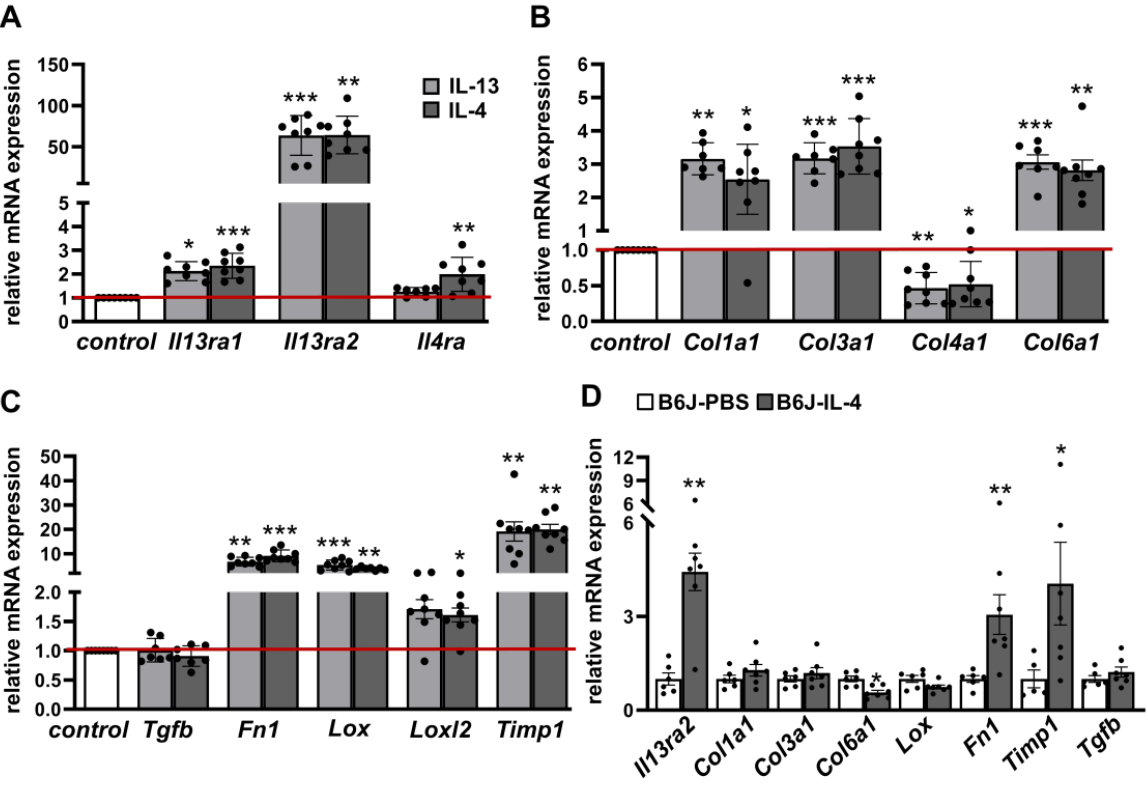
Figure 1. IL-13 and IL-4 induce fibrosis-related genes in adipose tissue of C3H mice and partial in WAT from B6J mice injected with IL-4. White adipose tissue (WAT) explants from C3H mice (n = 7–8) were stimulated either with IL-13 (50 ng/mL) or IL-4 (50 ng/mL) or non-stimulated (control) for four days. mRNA expression of cytokine receptors ( A ), collagens ( B ) and other fibrosis markers ( C ) are given as fold change compared to control condition. B6J mice were fed HFD over 6 weeks and were injected every two days with recombinant mouse IL-4 (66 µ g/kg body weight) complexed with anti-IL-4 (333 µ g/kg body weight) or PBS intraperitoneally (i.p.) for the final 2 weeks of feeding (n = 5–7). mRNA expression of Il13ra2 and fibrosis markers are given as fold change compared to PBS condition ( D ). Data represented as mean ± SEM. * p -value < 0.05; ** p -value < 0.01; *** p -value < 0.001. The red line indicates the level of the control group.